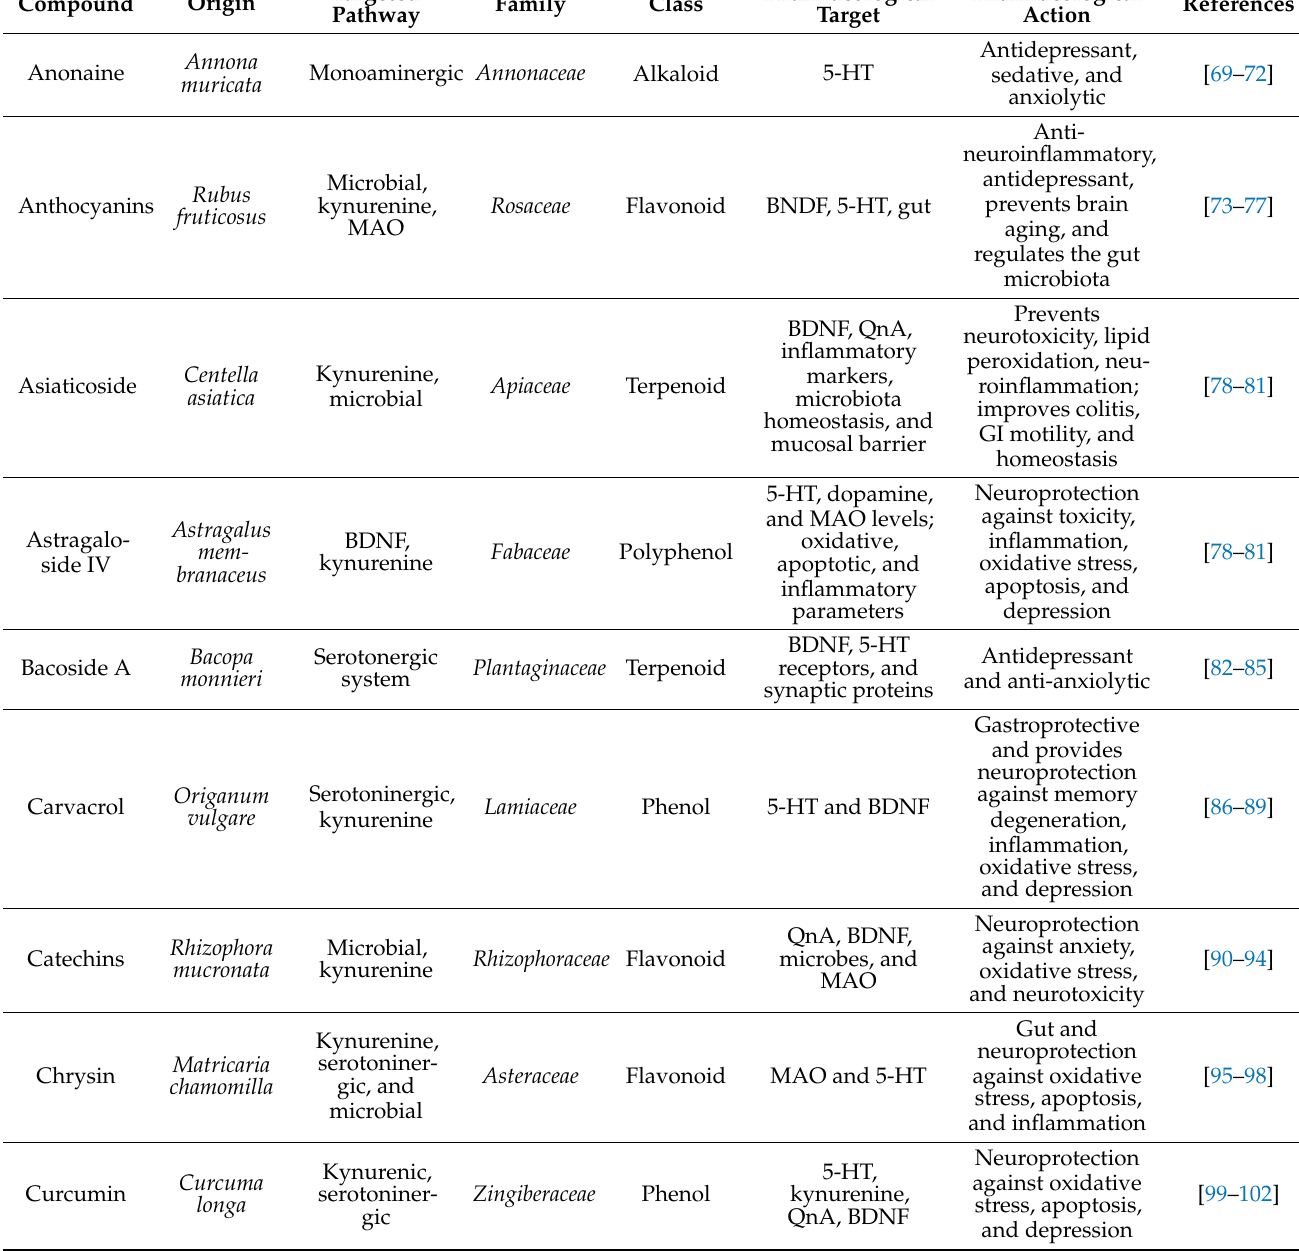
Table 1. Natural products and the derived potential compounds that exhibit gastroprotective and neuroprotective effects through regulating the GBA targeting